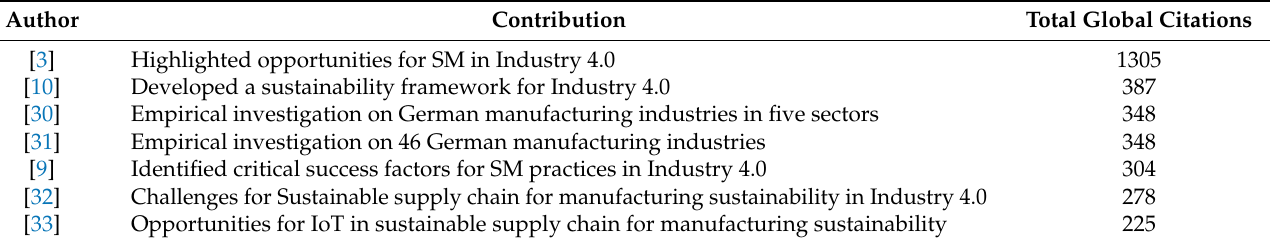
Table 1. Most cited articles (global